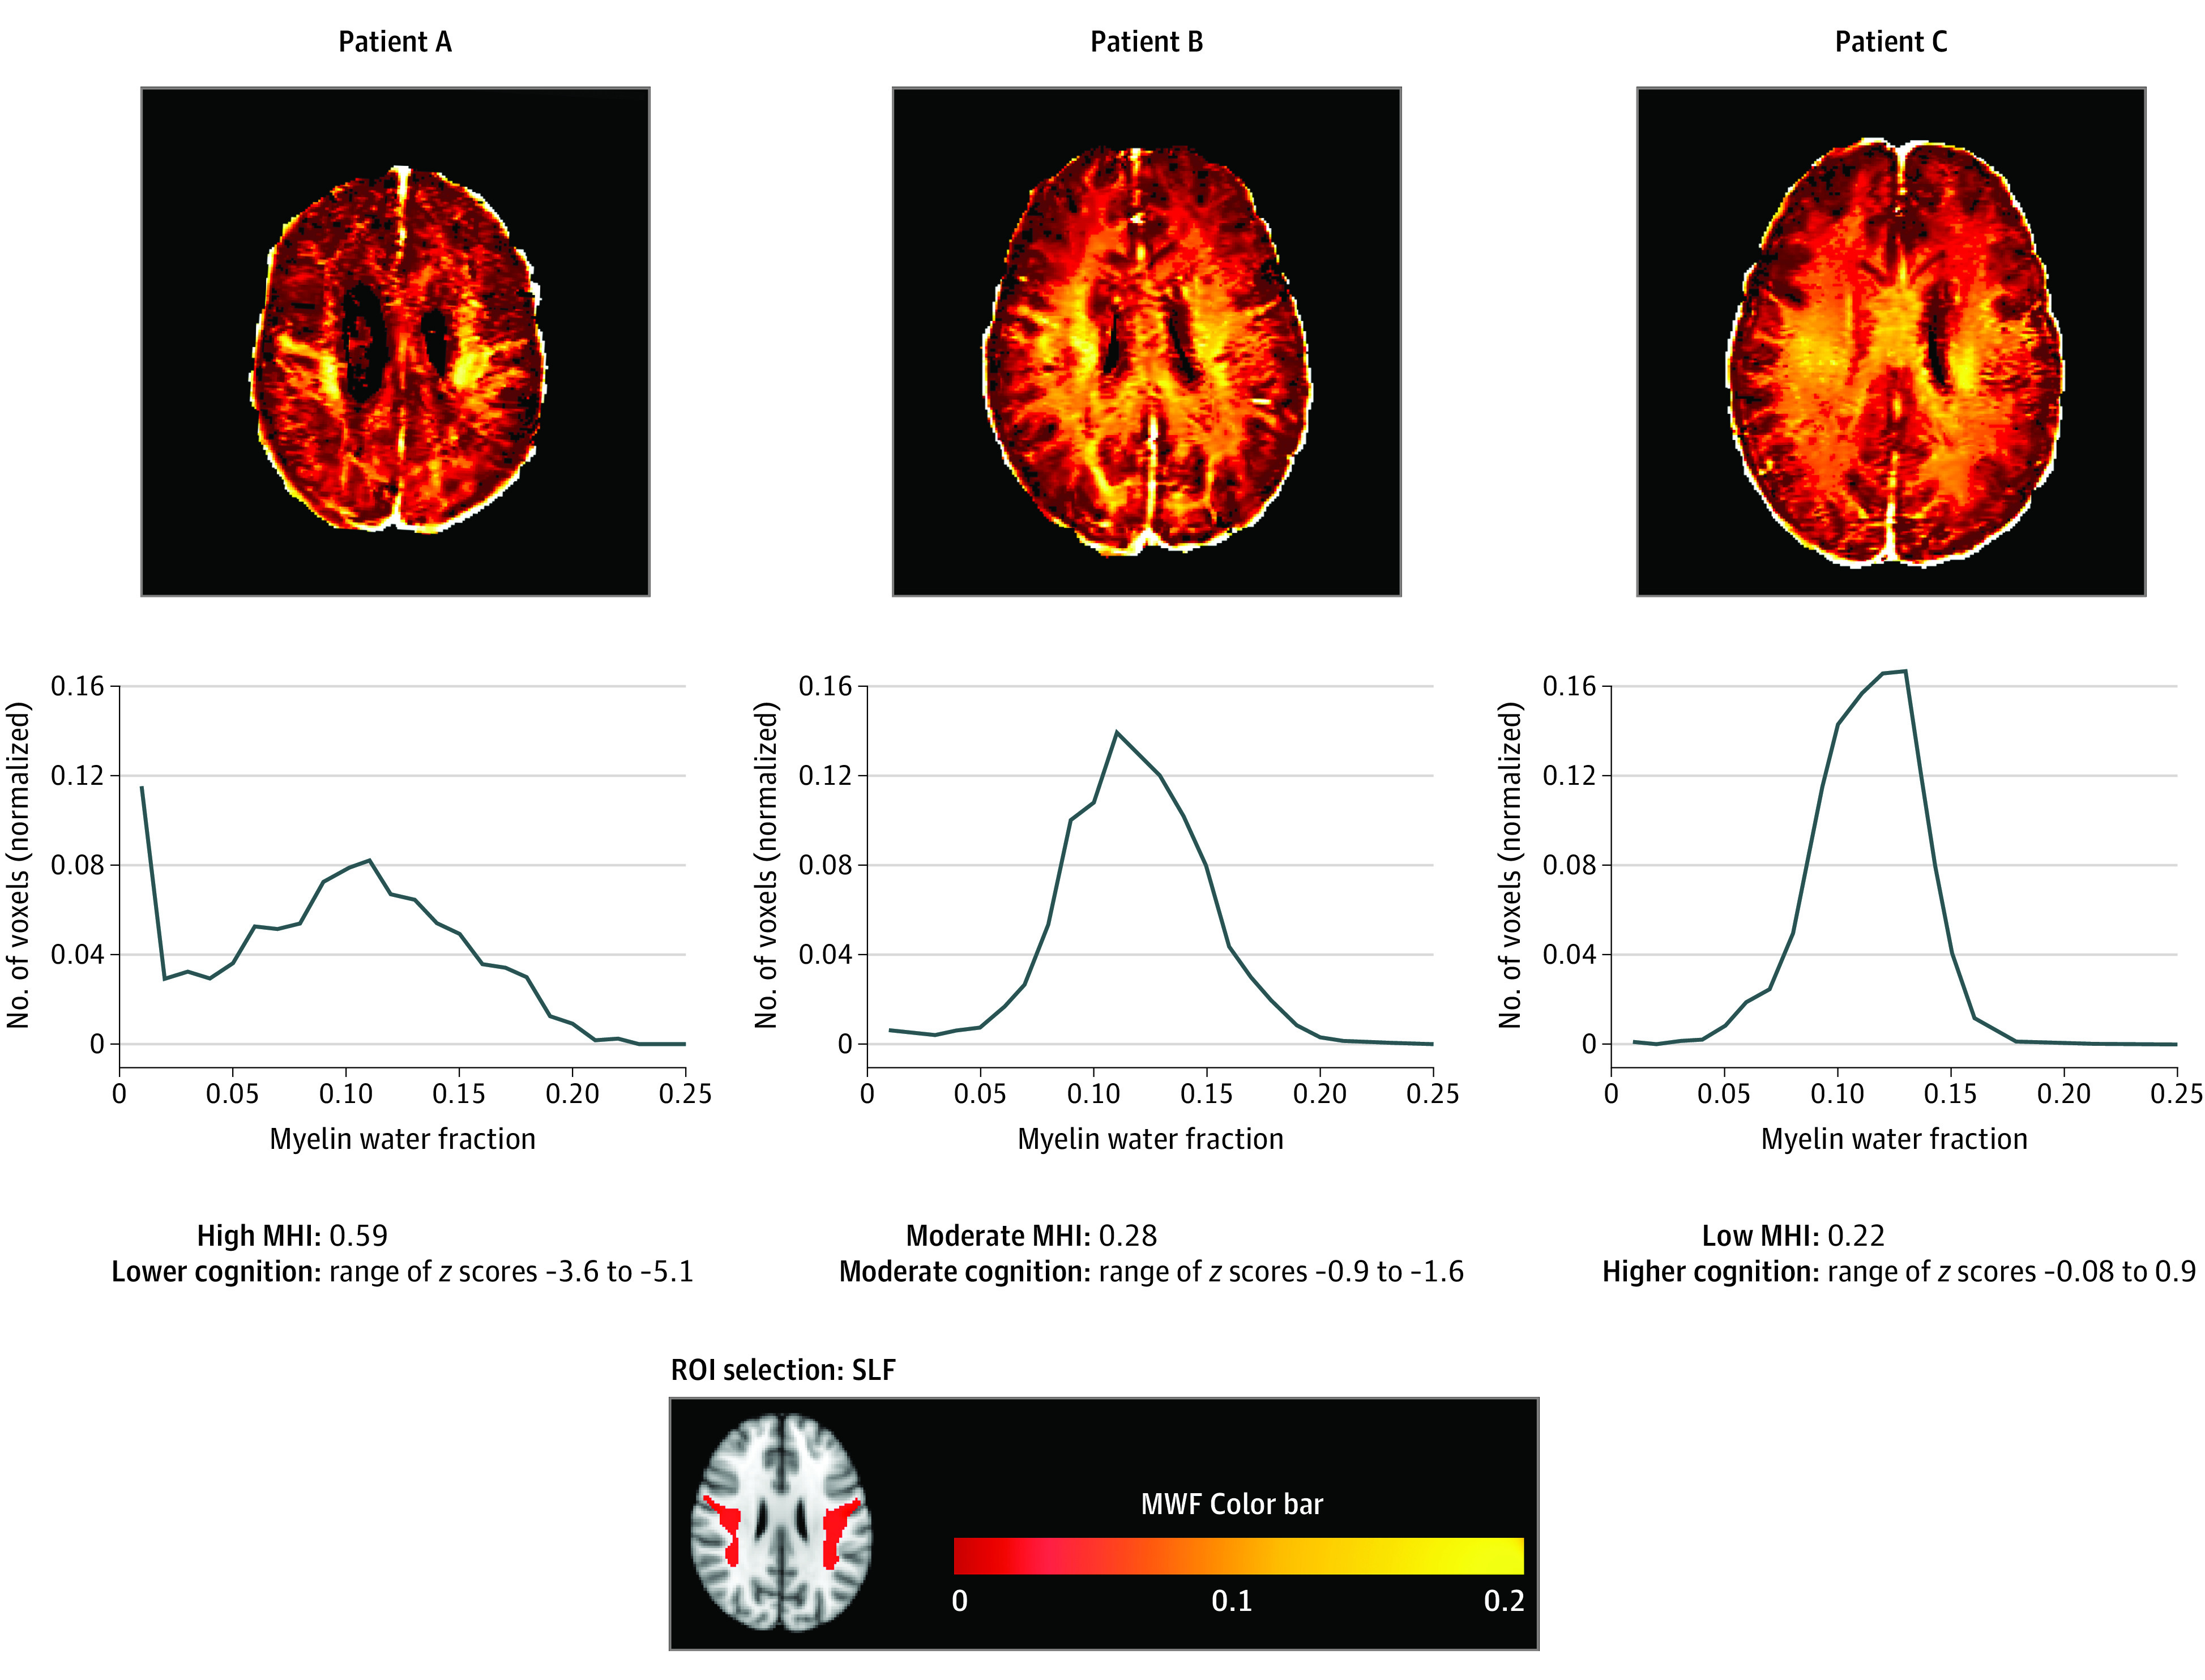
Axial Map of Myelin Water Fraction (MWF) Values, MWF Distributions in Superior Longitudinal Fasciculus (SLF), Myelin Heterogeneity Index (MHI) in SLF, and Cognitive z Scores in 3 Participants with Multiple SclerosisAxial maps of MWF values (top), normalized histograms of MWF values in the SLF (middle), MHI in the SLF and cognitive z scores (bottom) of 3 participants with multiple sclerosis. Patient A had a high MHI in the SLF (0.59), matching their low cognitive scores compared with controls (range of z scores, −5.1 to −3.6). Patient B had both moderate MHI in the SLF (0.28) and cognitive test scores (range of z scores, −1.6 to −0.9). Patient C had a low MHI in the SLF (0.22) and performed at and above the level of controls on the cognitive tests range of z scores (−0.08 to 0.9). The z scores were calculated using the mean and SD for each cognitive test from the control sample. ROI indicates region of interest.